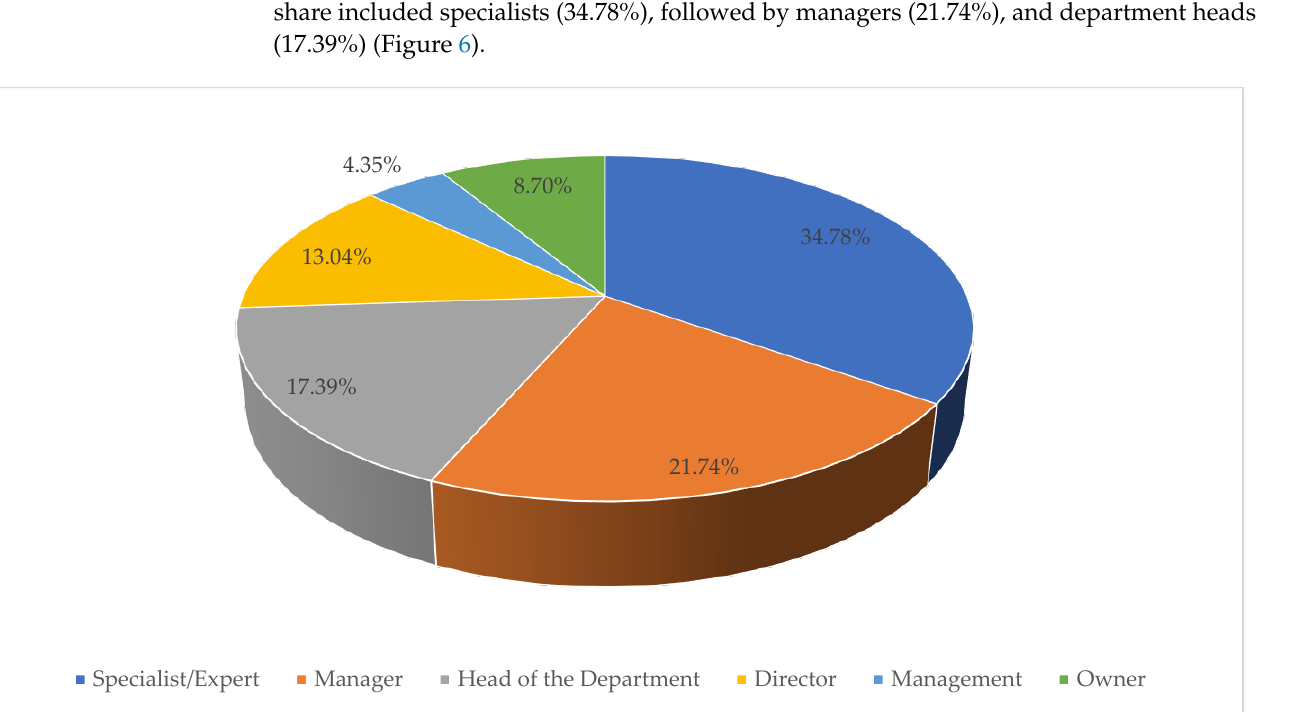
Figure 7. Experience of the participating experts, in years, on their last respective function. Source: Own study. The experts also indicated high levels of their respective knowledge on the issues related to smart city concepts, solutions, and technologies. The assumed scoring scale was from 1 to 5 (where 1 means a low level of knowledge and experience and 5 indicates a high level of knowledge and experience). A total of 78.26% of all answers had the highest values of 4 and 5 (Figure 8).